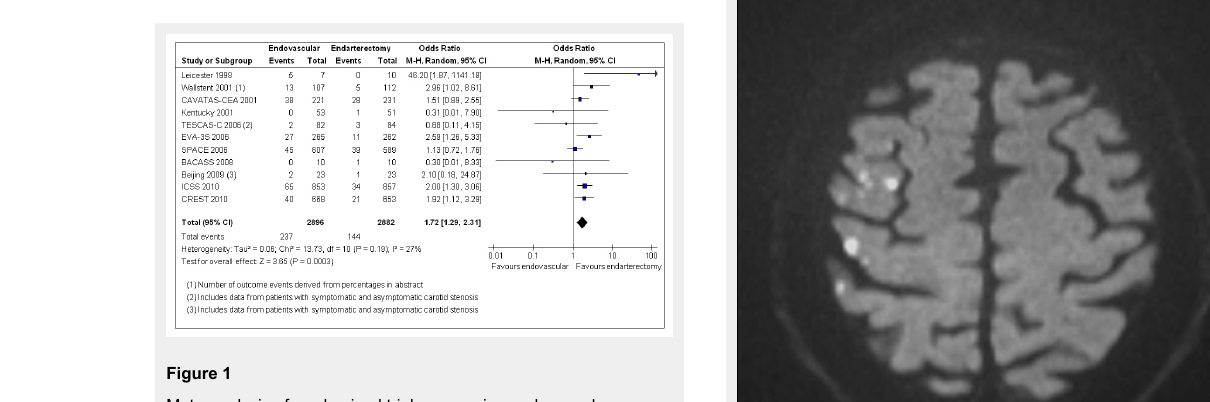
Meta-analysis of randomised trials comparing endovascular treatment with endarterectomy for symptomatic carotid stenosis: any stroke or death between randomisation and 30 days after treatment. Data are numbers of patients with events, total numbers of patients and Mantel-Haenszel random-effects odds ratios including 95% confidence intervals (CI) with endarterectomy as the reference treatment. Squares on the right represent point estimates of odds ratios at trial level, with 95% CI as horizontal bars. The diamond at the bottom represents the summary OR and 95% CI. Data from the following trials are included: Leicester [46], Wallstent [47], CAVATAS [13], Kentucky [48], TESCAS-C [49], EVA-3S [14], SPACE [16], BACASS [50], Beijing [51], ICSS [17], CREST [18].